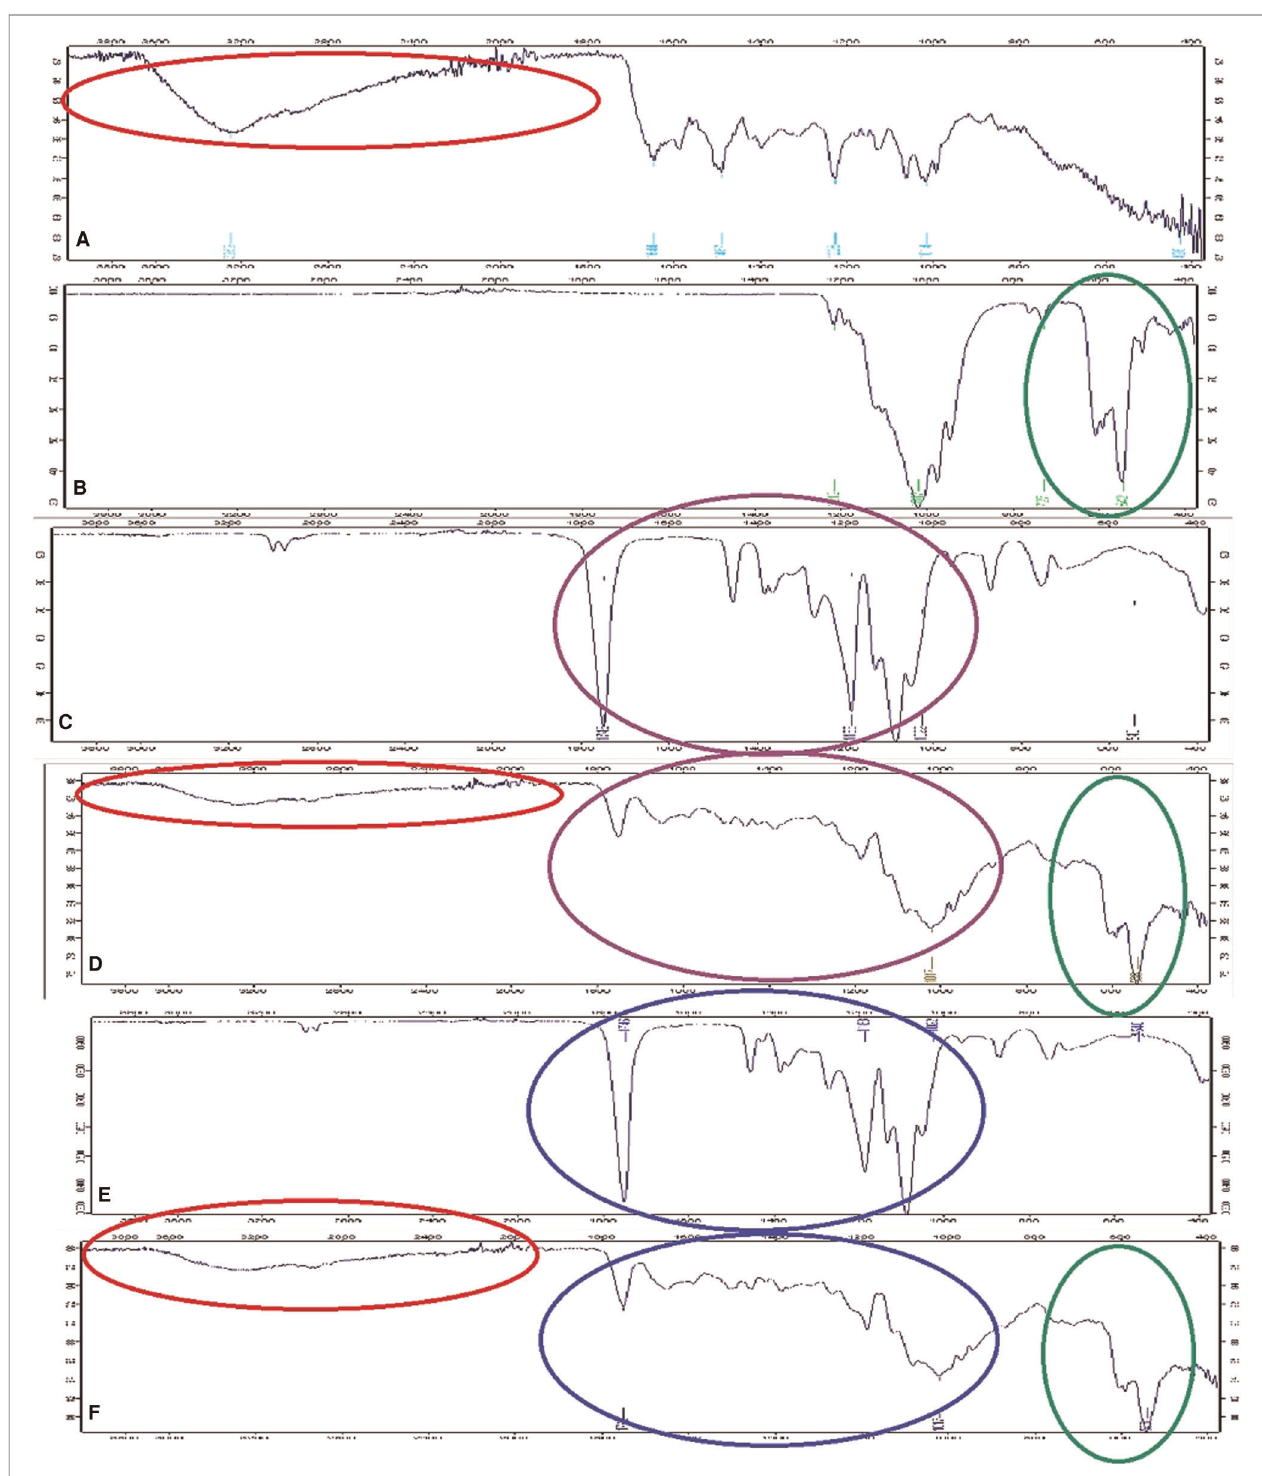
FIGURE 3 | FTIR spectra of ( A ) vancomycin, ( B ) β -TCP, ( C ) PDLLA, ( D ) vancomycin containing PDLLA/ β -TCP composite, ( E ) PLGA, and ( F ) vancomycin containing PLGA/ β -TCP composite. PDLLA, poly( D , L -lactide); PLGA, poly( D , L -lactide-co-glycolide); β -TCP, beta-tricalcium